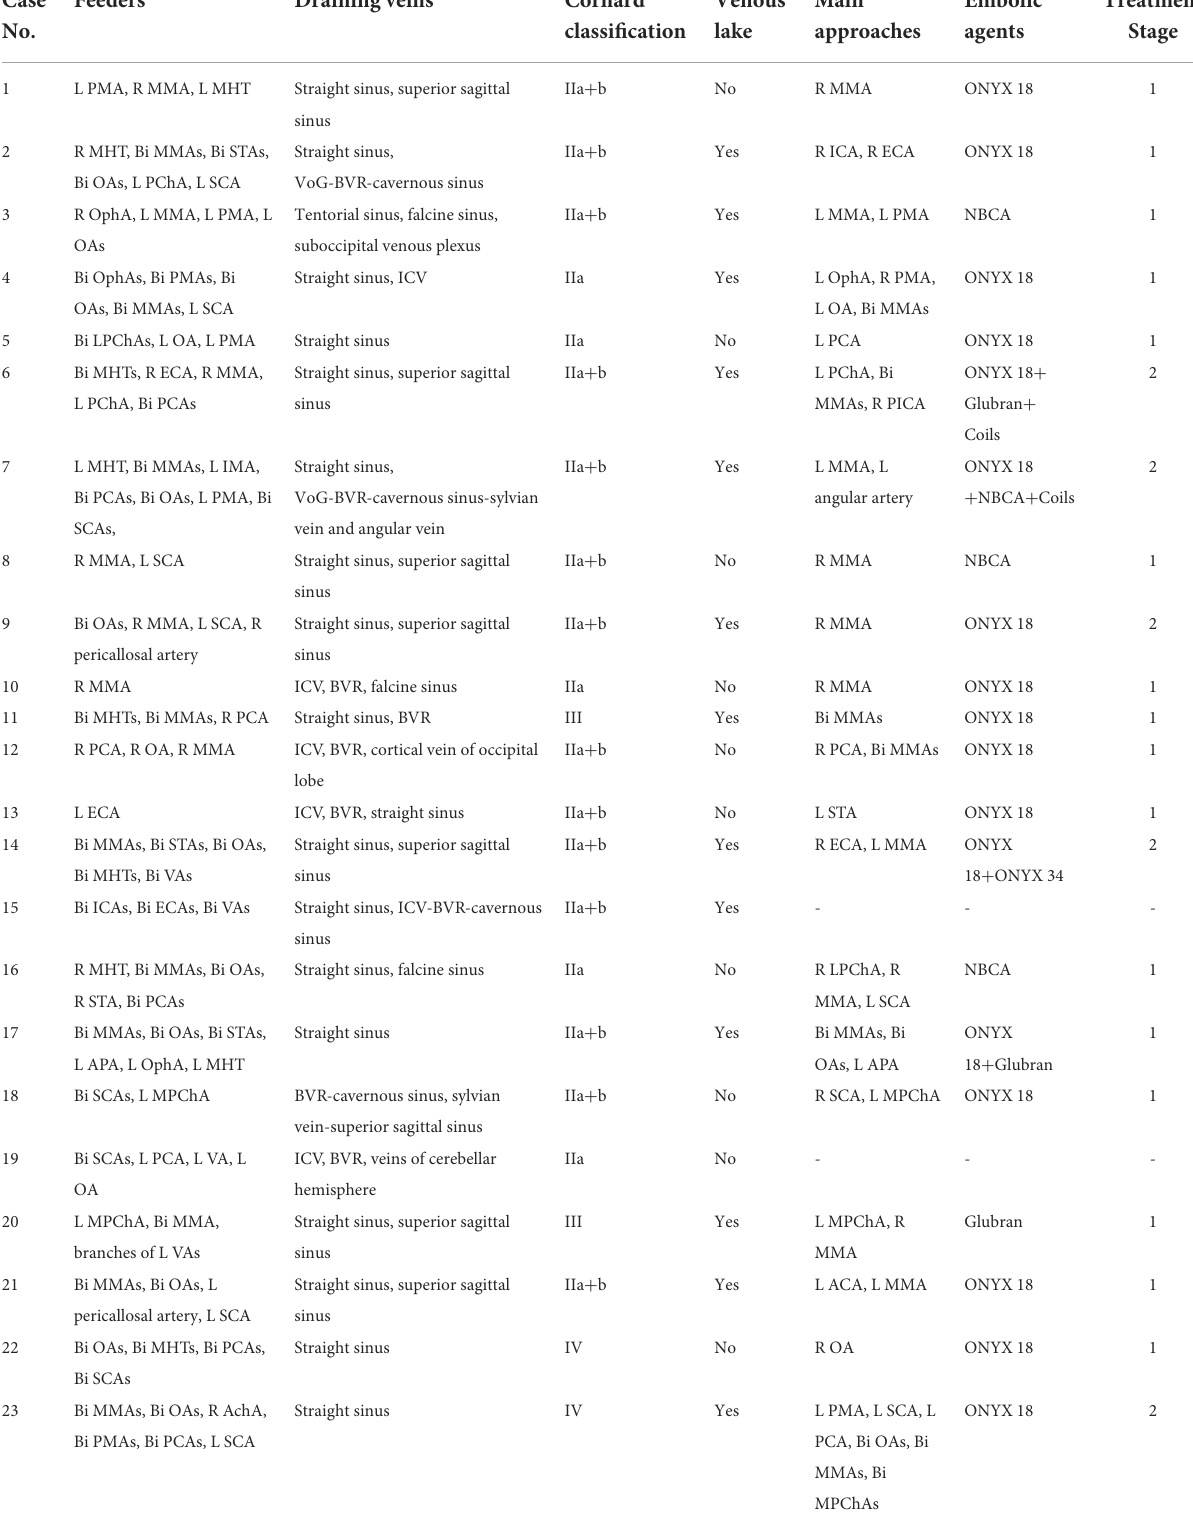
TABLE 2 Angiographic characteristics and treatment